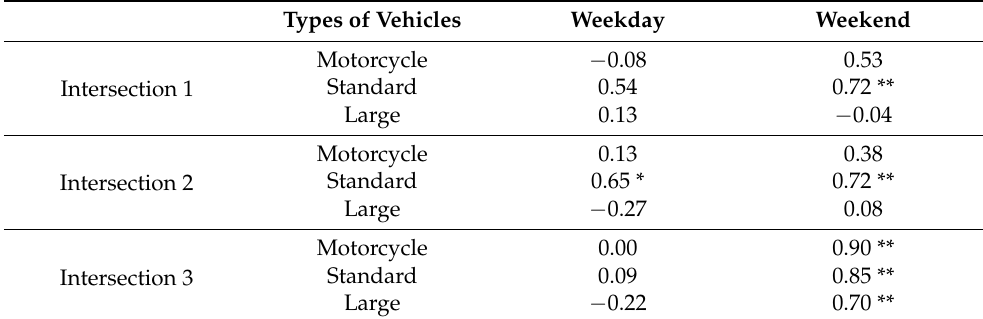
Table 5. Correlation coefficient between the traffic volume of each type of vehicle and the frequency of horn use. Types of Vehicles Weekday Weekend Motorcycle − Intersection 1